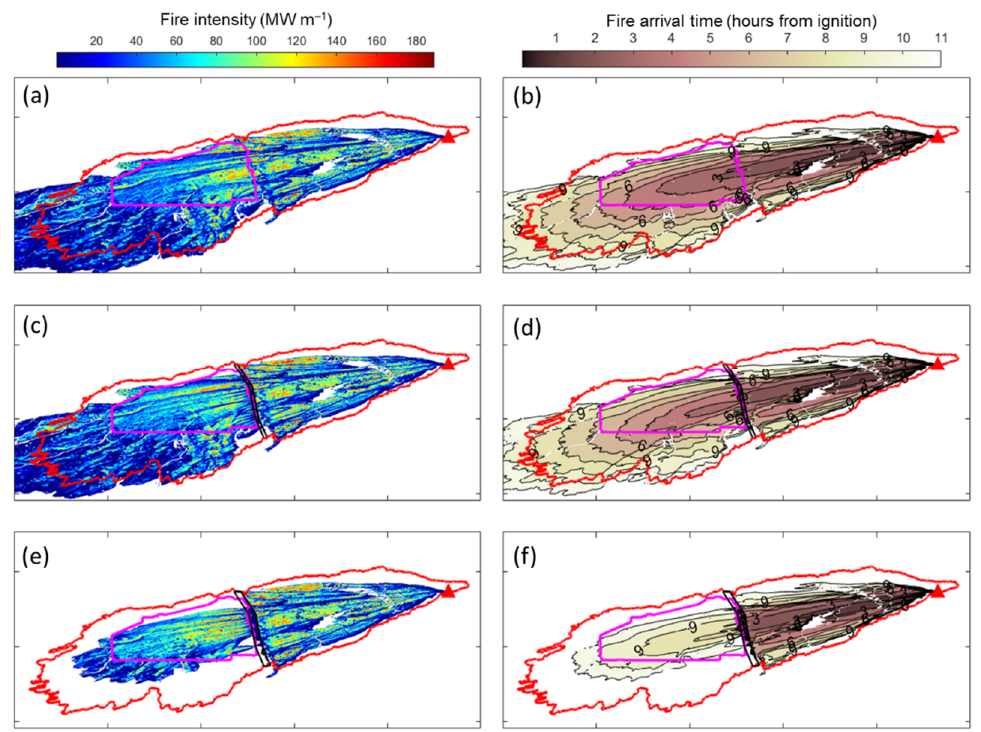
Figure 3. Simulated fire intensity ( left ) and fire arrival time in hours after 06:30 PST ignition ( right ) for the verification simulation ( a , b ), 200 m-wide ( c , d ) and 400 m-wide ( e , f ) WUI fuel break scenarios. The locations of the 2018 Camp Fire ignition and WUI fuel break are indicated with a red triangle and black polygon, respectively. Observed burn perimeter at 18:00 PST on 8 November is shown using a red polygon. The Paradise Township boundary is shown with a magenta polygon. In panels ( a , c , e ), the color bar represents fire intensity with warmer colors corresponding to higher intensities. In panels ( b , d , f ), the colors correspond to fire arrival times in hours since 06:30 PST, with darker colors corresponding to earlier arrival times.